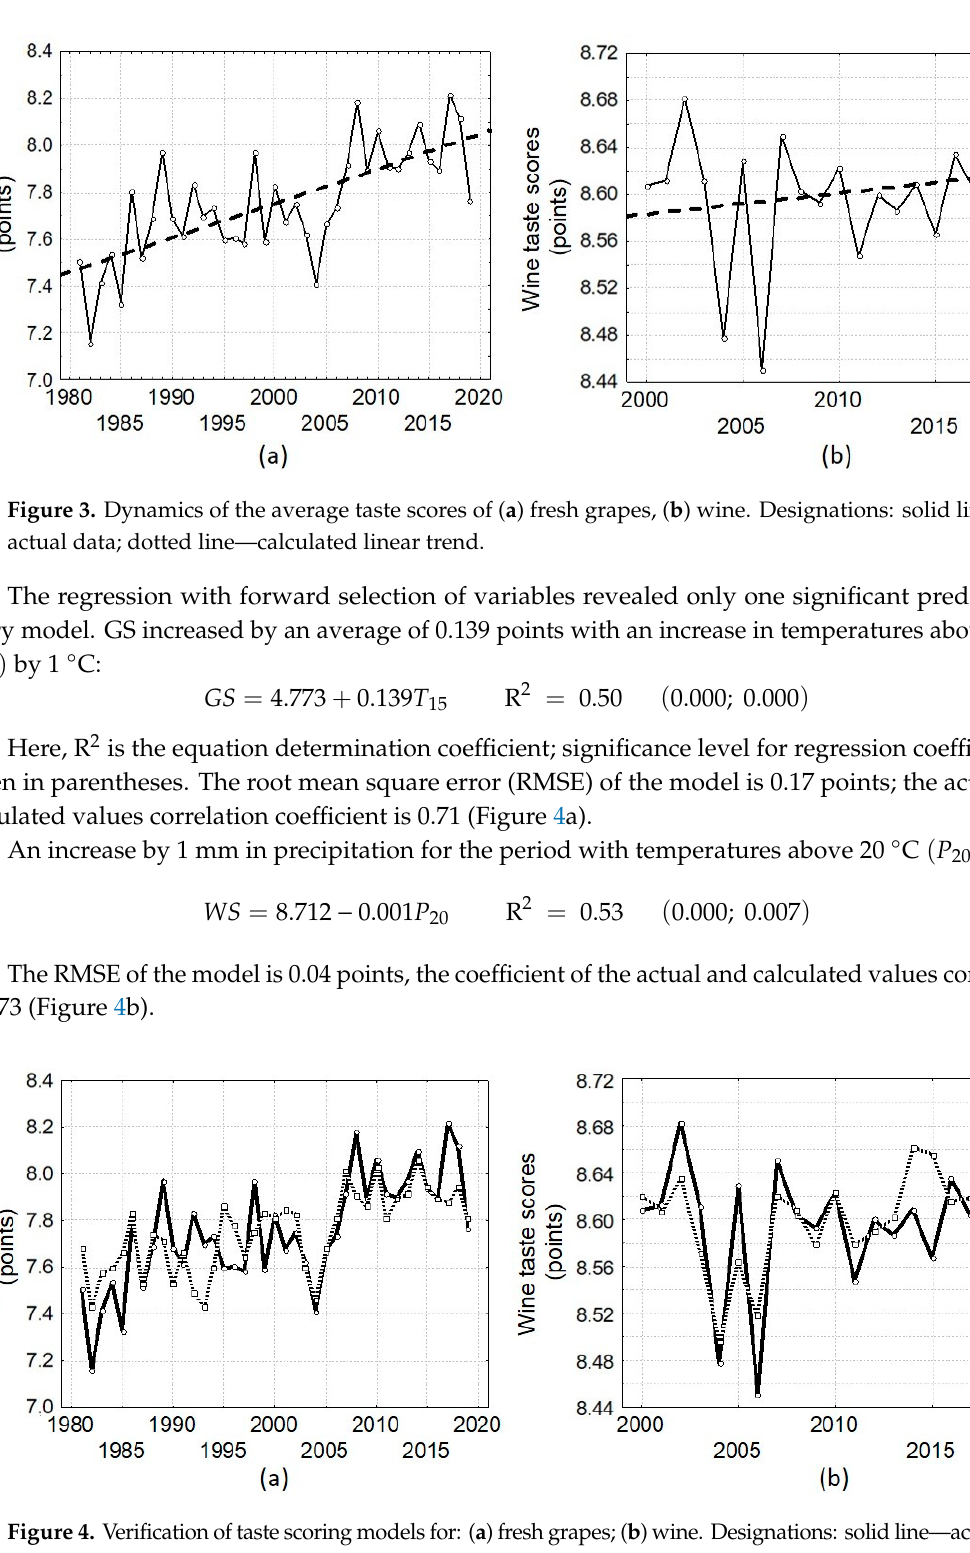
Figure 4. Verification of taste scoring models for: ( a ) fresh grapes; ( b ) wine. Designations: solid line—actual values, dotted line—calculated values.